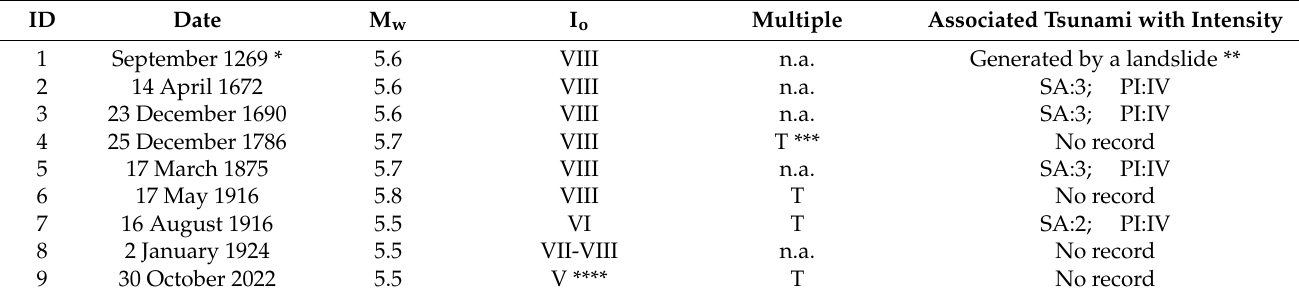
Table 1. Historical and instrumental earthquakes with M w ≥ 5.5 of the study area (Figure 1; CPTI15; Rovida et al. [18]; CFTI5Med; Guidoboni et al. [21]), and tsunami with their intensity (EMTC; Maramai et al. [22]). T: true; SA: Intensity Sieberg–Ambraseys scale; PI: Intensity Papadopoulos and Imamura scale; * unspecified day; ** the earthquake triggered a large landslide that fell into the sea on the eastern side of Monte Conero (CFTI5Med [21]); *** some historical sources describe the occurrence of a second large earthquake one hour after the first event (CFTI5Med [21]); **** EMS-98 scale; Tertulliani et al.